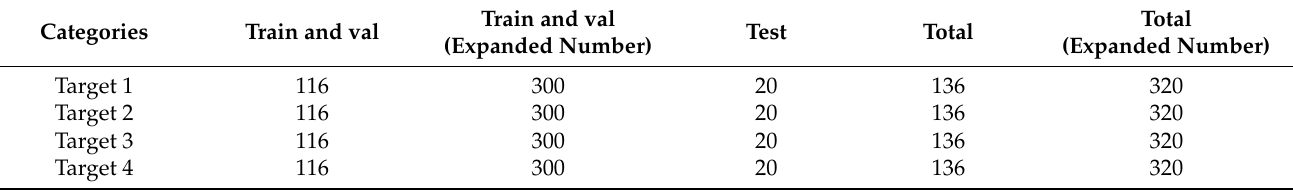
Table 3. Experimental data